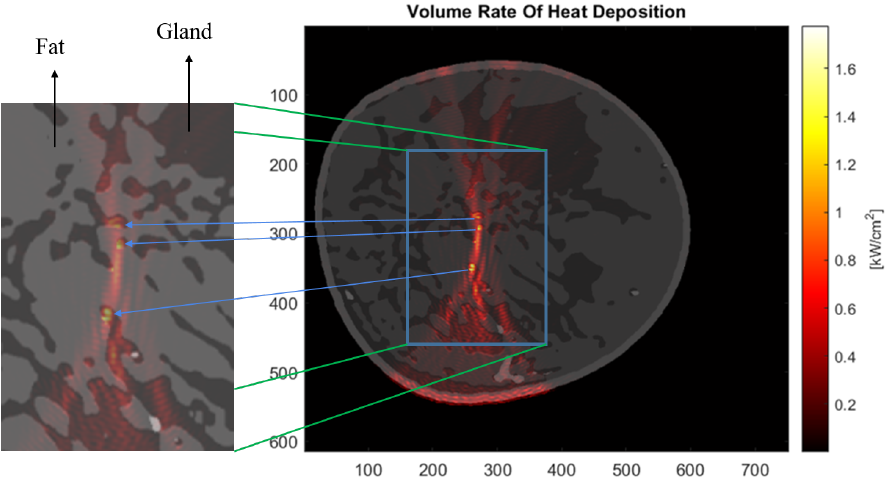
Figure 6. Distribution map of the heat deposition rate per unit area for the extremely dense-type breast. The zoomed-in copy cutout shows that the rate peaks in the fibroglandular tissues present in the vicinity of the focal region of the HIFU.